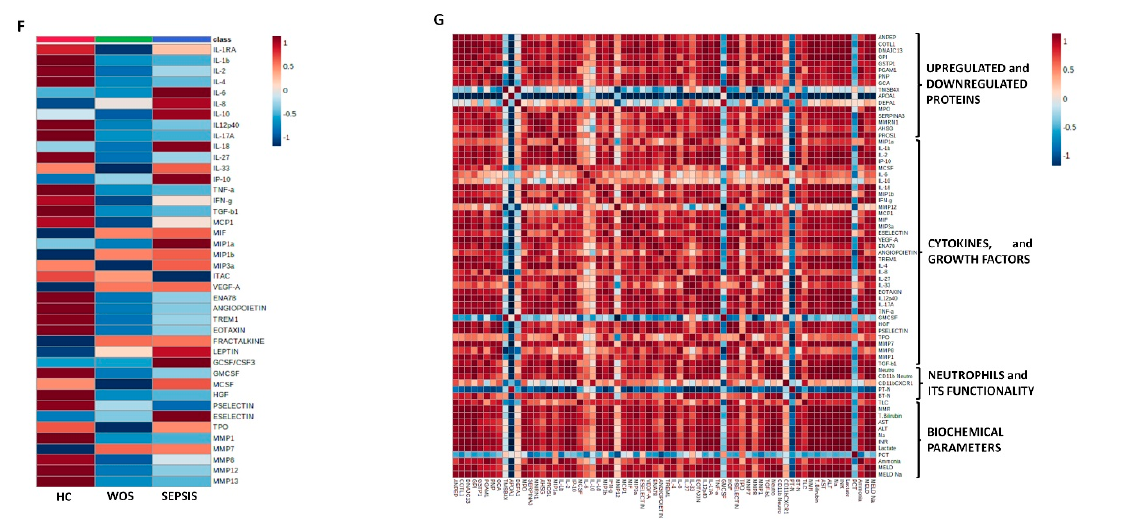
Figure 5. Identification of proteins, and cytokines linked with neutrophils. ( A ) Schematic representation of the work pipeline followed for proteomics and cytokine bead array. ( B ) Principal component analysis (PCA) between the groups. ( C ) Venn diagram showing total upregulated and downregulated proteins between the groups. ( D ) Few upregulated and downregulated proteins related to neutrophil activity which were found significant between the groups. ( E ) Heatmap showing these upregulated and downregulated proteins between the groups. ( F ) Cytokine bead array analysis between the groups. ( G ) Correlation matrix among %neutrophils, proteins, cytokines, and biochemical parameters in sepsis patients. It was obtained by deriving a Pearson correlation coefficient. Red is a positive correlation, and blue is a negative